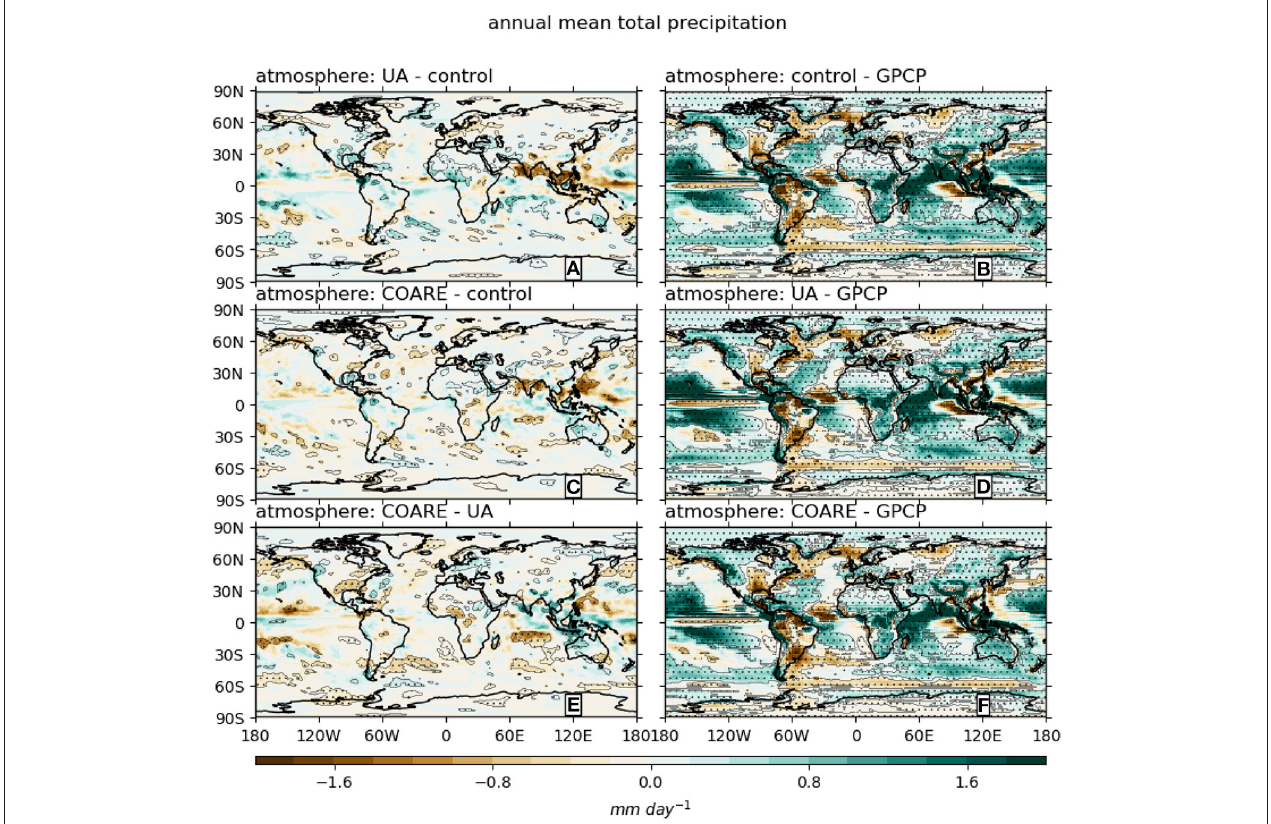
FIGURE 6 | Differences in annual mean precipitation climatology between simulations with different bulk flux algorithms (left column) and annual mean precipitation biases relative to GPCP (right column). Stippling designates regions where the absolute value of the difference is larger than the interannual standard deviation from the E3SMv1 pre-industrial control